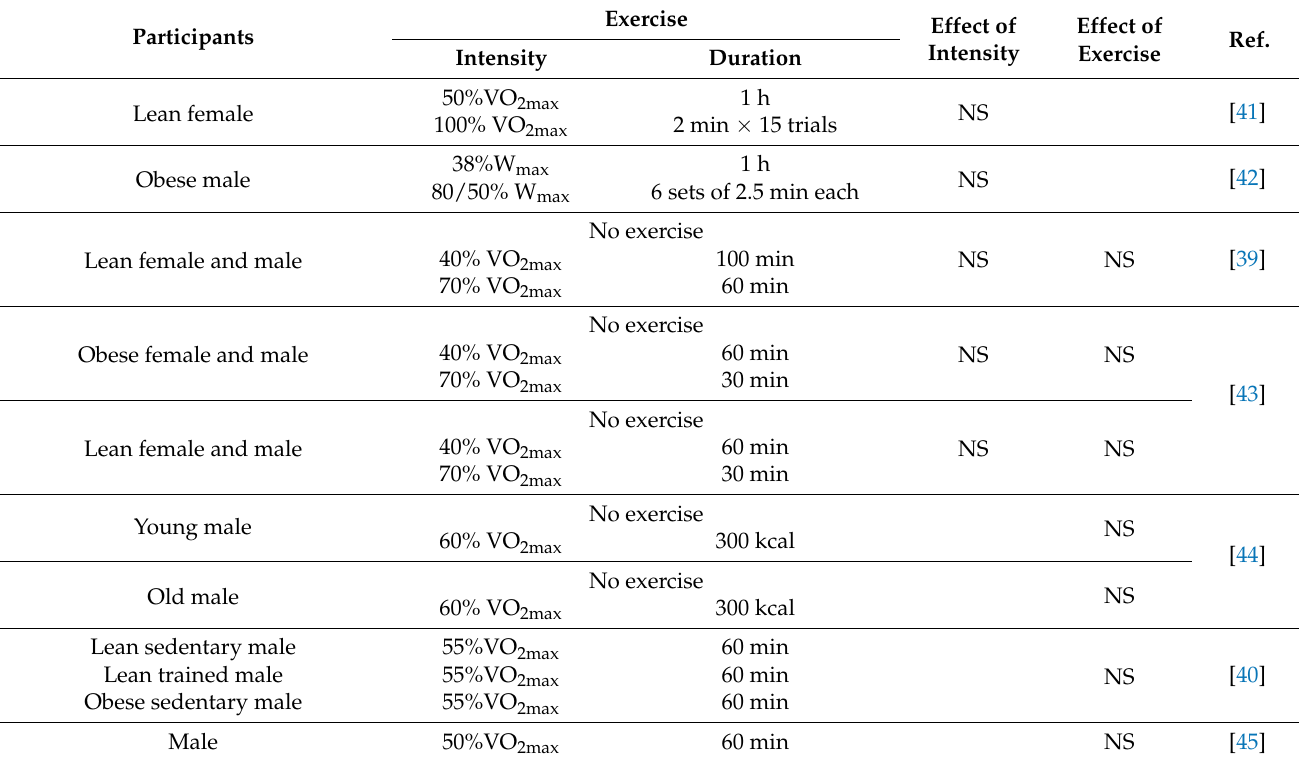
Table 1. Effects of exercise on accumulated fat oxidation over 24 h under an energy-balanced